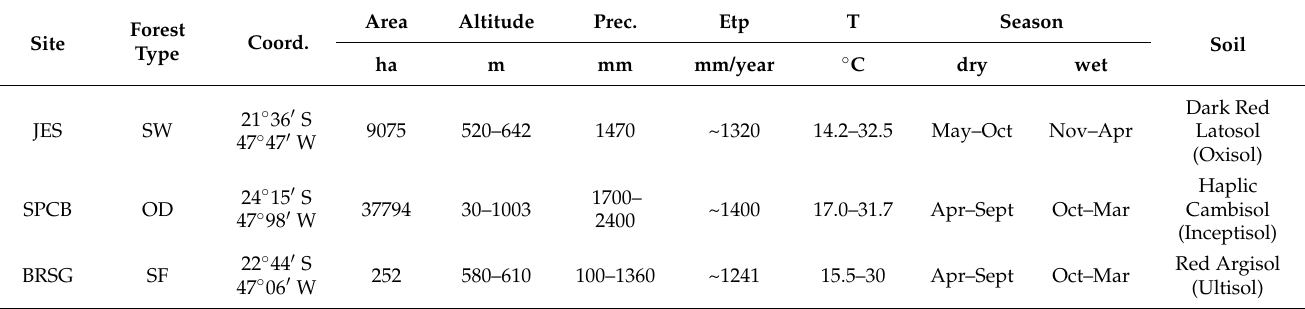
Table A1. Abiotic characteristics of the protected areas studied. Savanna Woodland (SW)—Jata í Ecological Station (JES), Ombrophylous Dense Forest (OD)—State Park of Carlos Botelho (SPCB) and Semideciduous Forest (SF)—Biological Reserve of Santa Genebra (BRSG), Brazil. Coord. = Geographic coordinates, Prec. = Precipitation, Et p = Potential evapotranspiration and T =